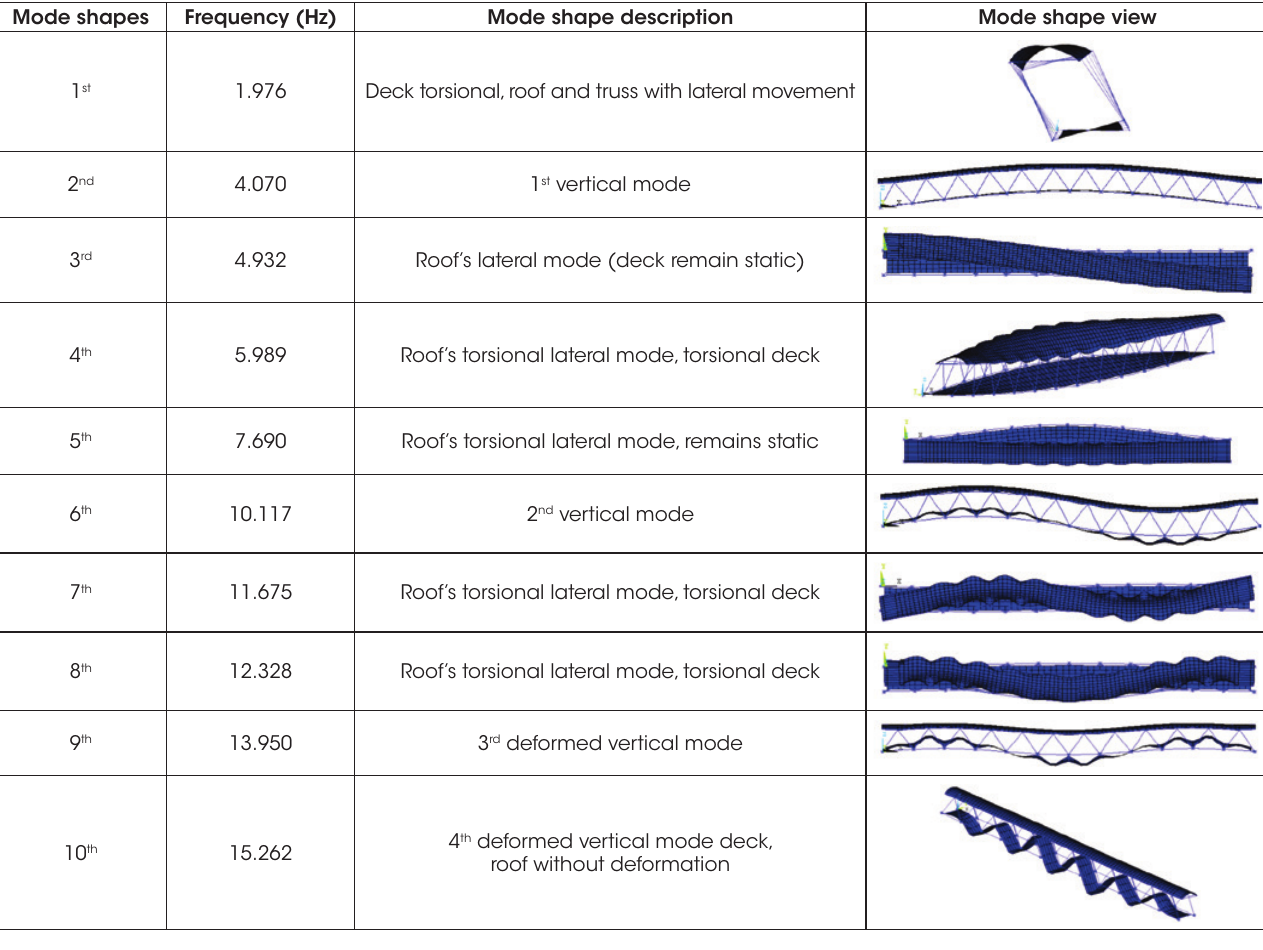
Analysis of free vibrations of the footbridge on E.P.I.A. ( Estrada Parque Indústria e Abastecimento ) – Model 2 (E = 1.72 x 10 11 N/m 2 )